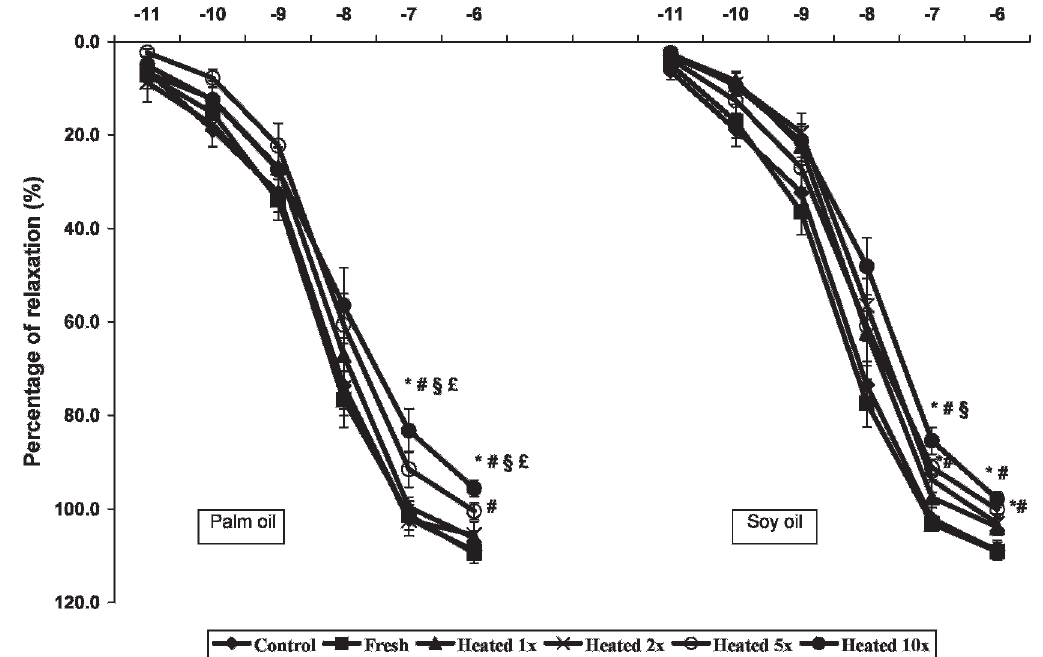
Figure 4 - Endothelium-independent relaxation induced by sodium nitroprusside (SNP) in aortic rings isolated from rats that were fed for 24 weekswith a basal diet (control), fresh palmor soyoil, or palmor soy oil thatwas heated once (1x), twice (2x), fivetimes (5x) or ten times (10x). The results are the means ¡ SEM (n=10) . Significant difference ( p , 0.05) versus the * control, # fresh-oil group, 1 1x heated-oil group, or £ 2x heated-oil group. Dose response curves are plotted as percentage of relaxation against the maximal phenylephrine (PE, 10 2 6